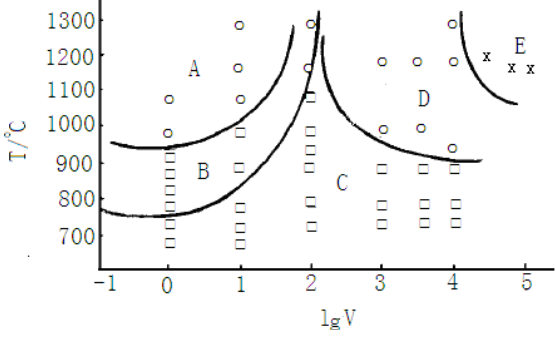
Figure 5. Relationship of the TiAl morphology with the melting temperature and cooling 3 rate [14]. ( A ) needle–like TiAl3 area; ( B ) mixture of blocky and needle–like TiAl ( C ) blocky TiAl area; ( D ) metastable area; ( E ) Ti supersatural solution 3